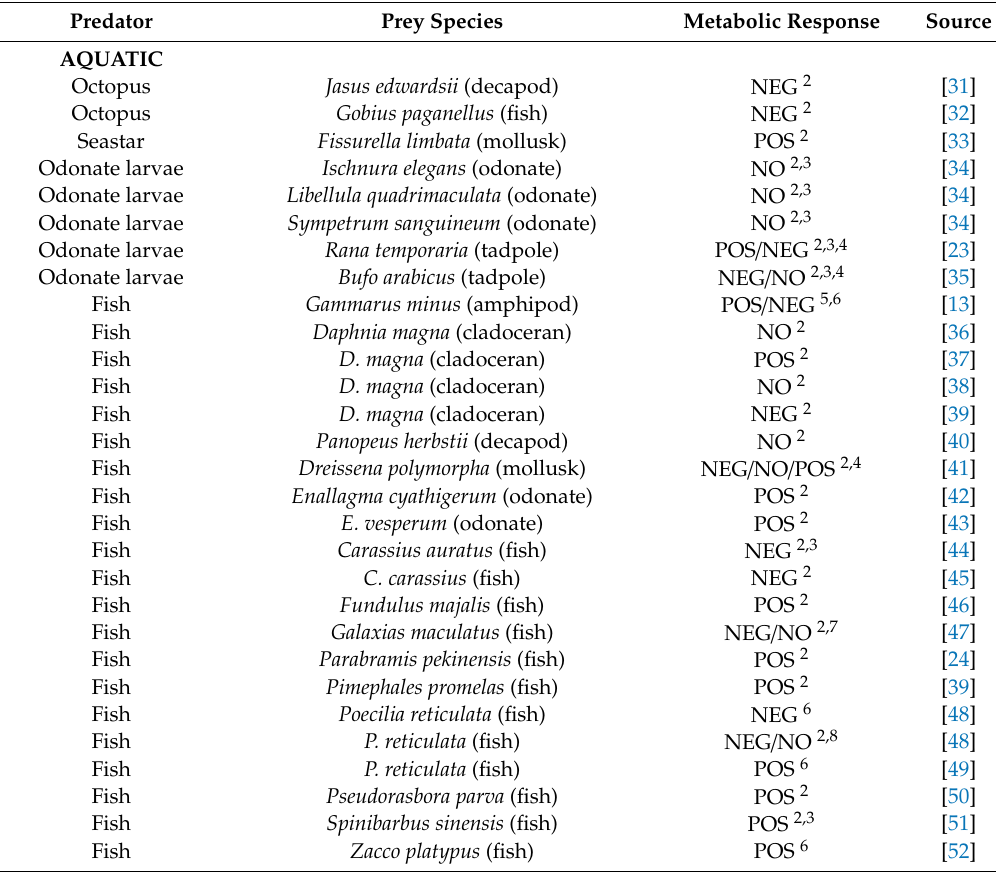
Table 1. Positive (POS), negative (NEG) or no (NO) e ff ects of predators or their cues on the resting or routine metabolic rate 1 of various prey